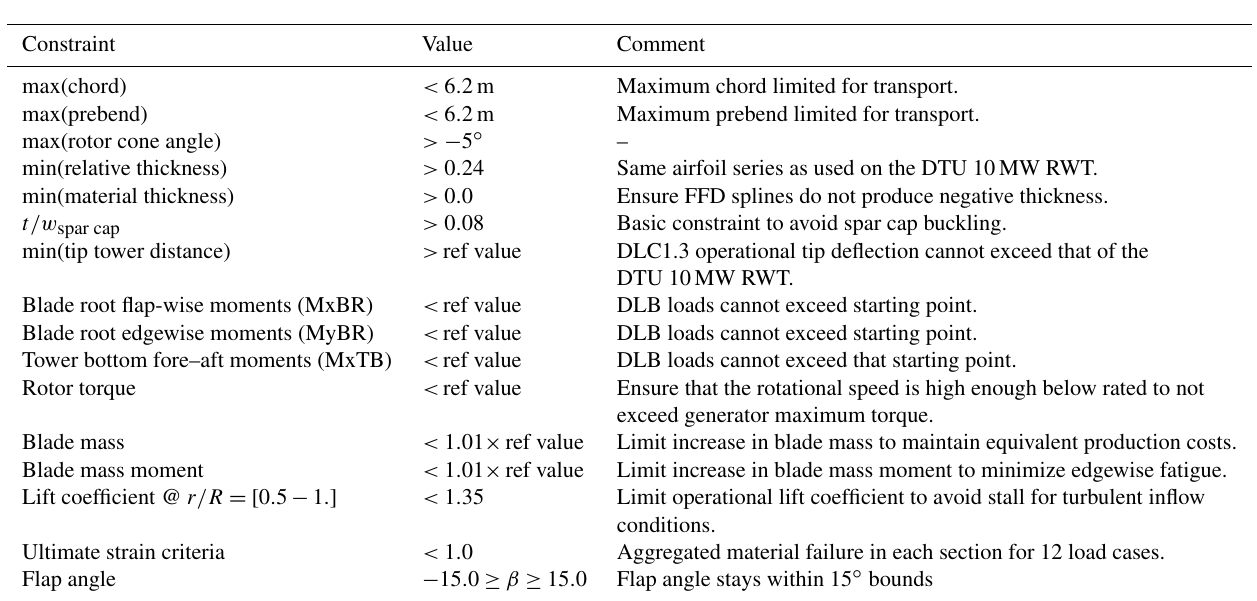
Table 4. Summary of optimization